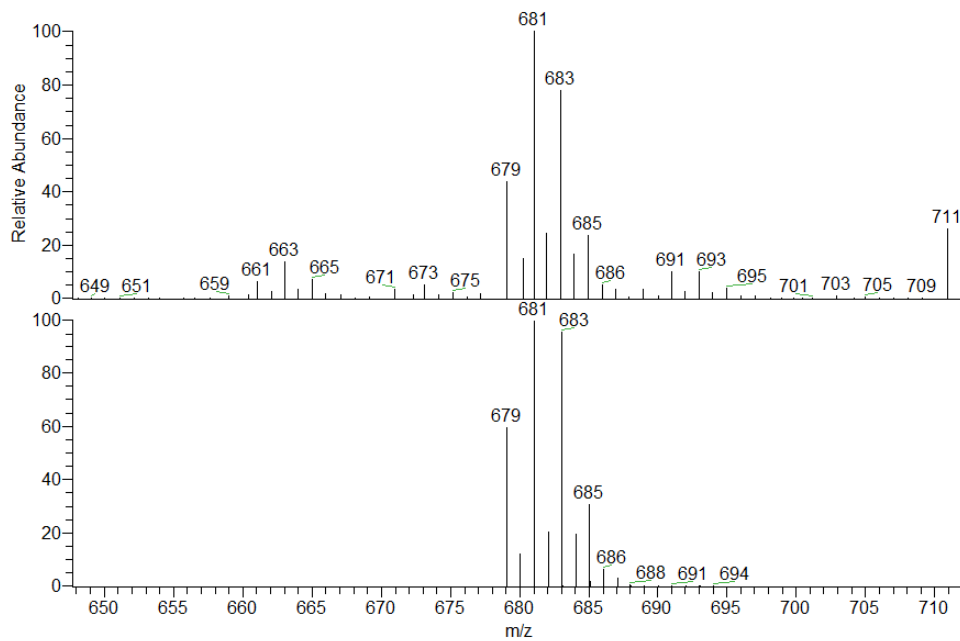
Figure 2. Experimental ( bottom ) and calculated ( up ) distribution for complex 8 [M + Cl] − . Via the recrystallization of compound 8 from a mixture of diethyl ether and methylene chloride, we obtained orange crystals suitable for XRD (Figure 3, Tables 1 and 2).